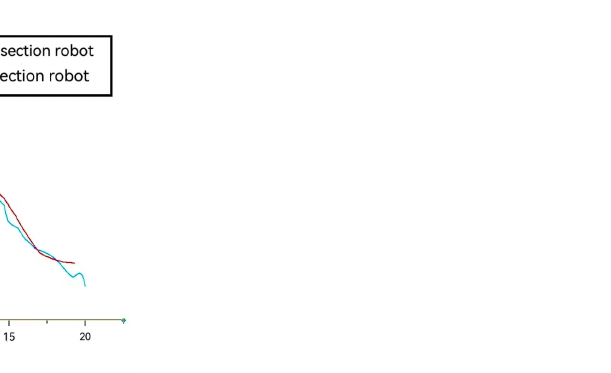
Figure 12 . Contact force of leather bowl with di ff erent numbers of compartments. Figure 12. Contact force of leather bowl with different numbers of